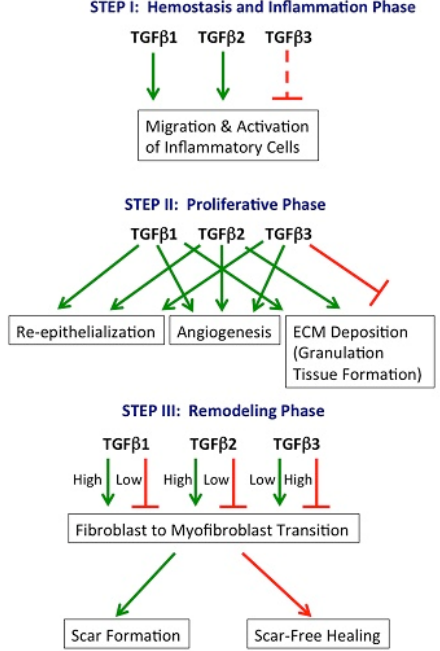
Figure 3. Transforming growth factor β (TGF- β ) isoforms and their role in wound healing—schematical representation [54].